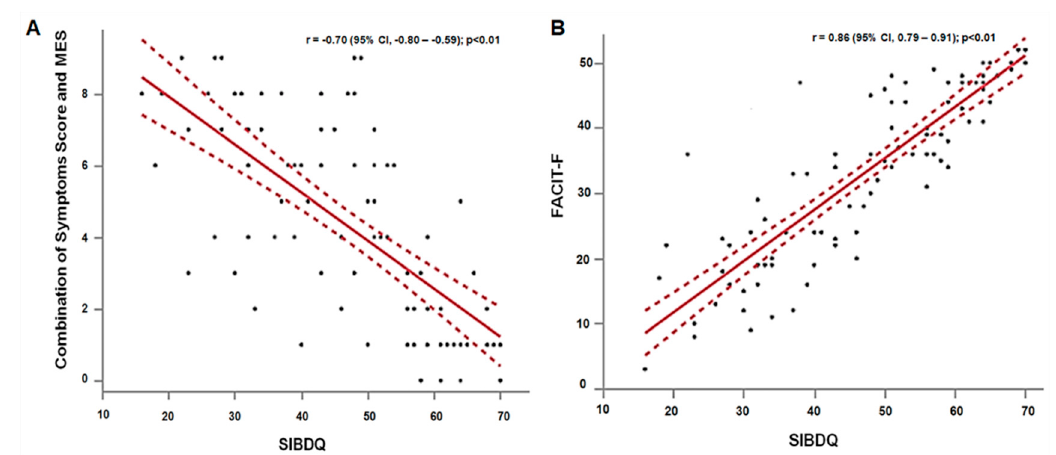
Figure 1. Correlations of ( A ) combination of ClinPRO2 and MES with SIBDQ and ( B ) SIBDQ with FACIT-F.